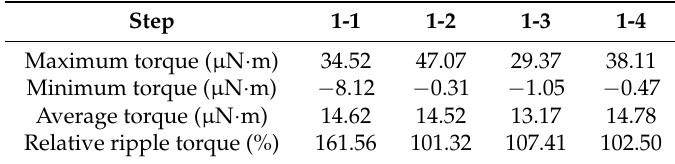
Table 2. Step 1: Comparison of the torque characteristics of each step.